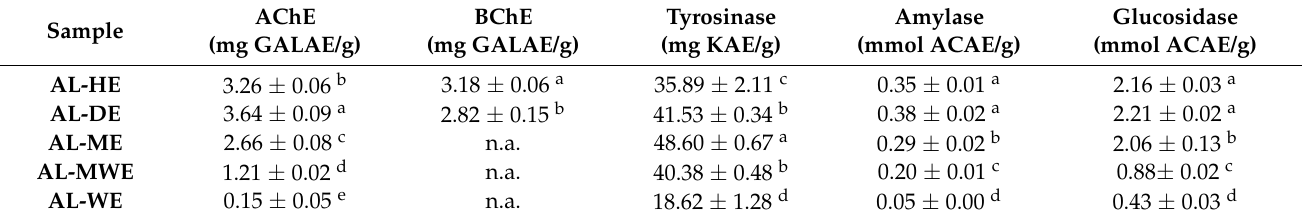
Table 4. Enzyme inhibitory activity of Artemisia campestris subsp. lednicensis extracts.